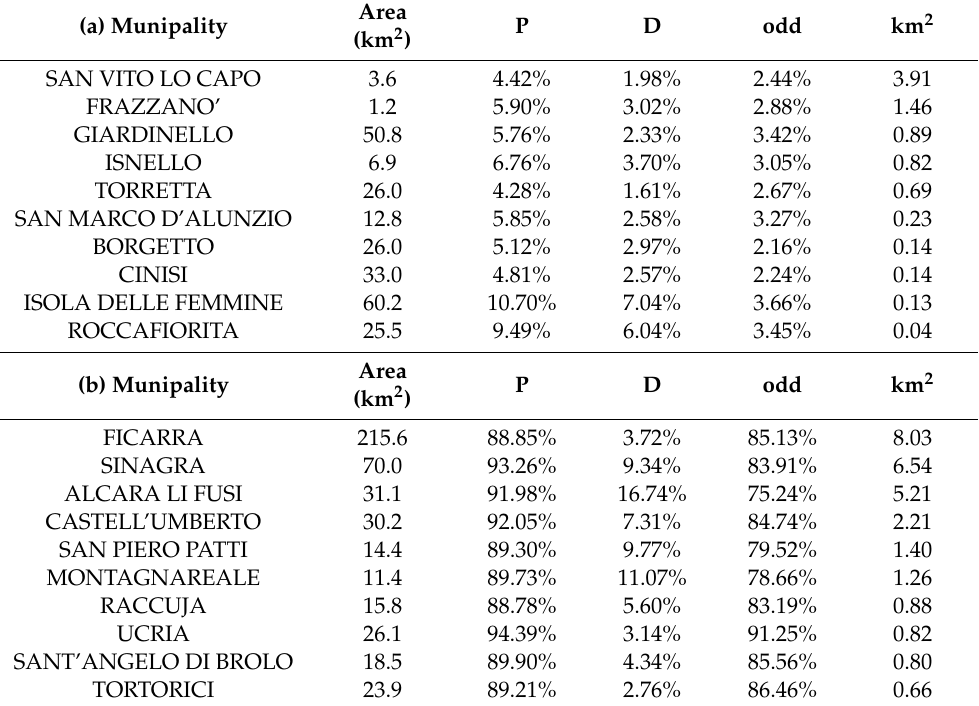
Table 8. The top 10 municipalities ordered according to the size of the area that may be a ff ected by new landslides in the future ((a) SCR_LSN in Table; (b)